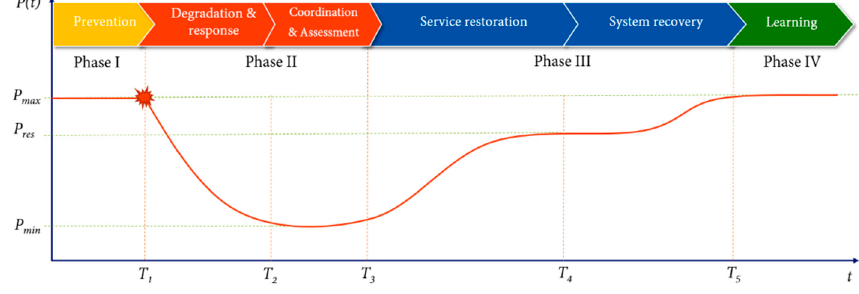
Figure 3. Performance curve for resilience quantification.